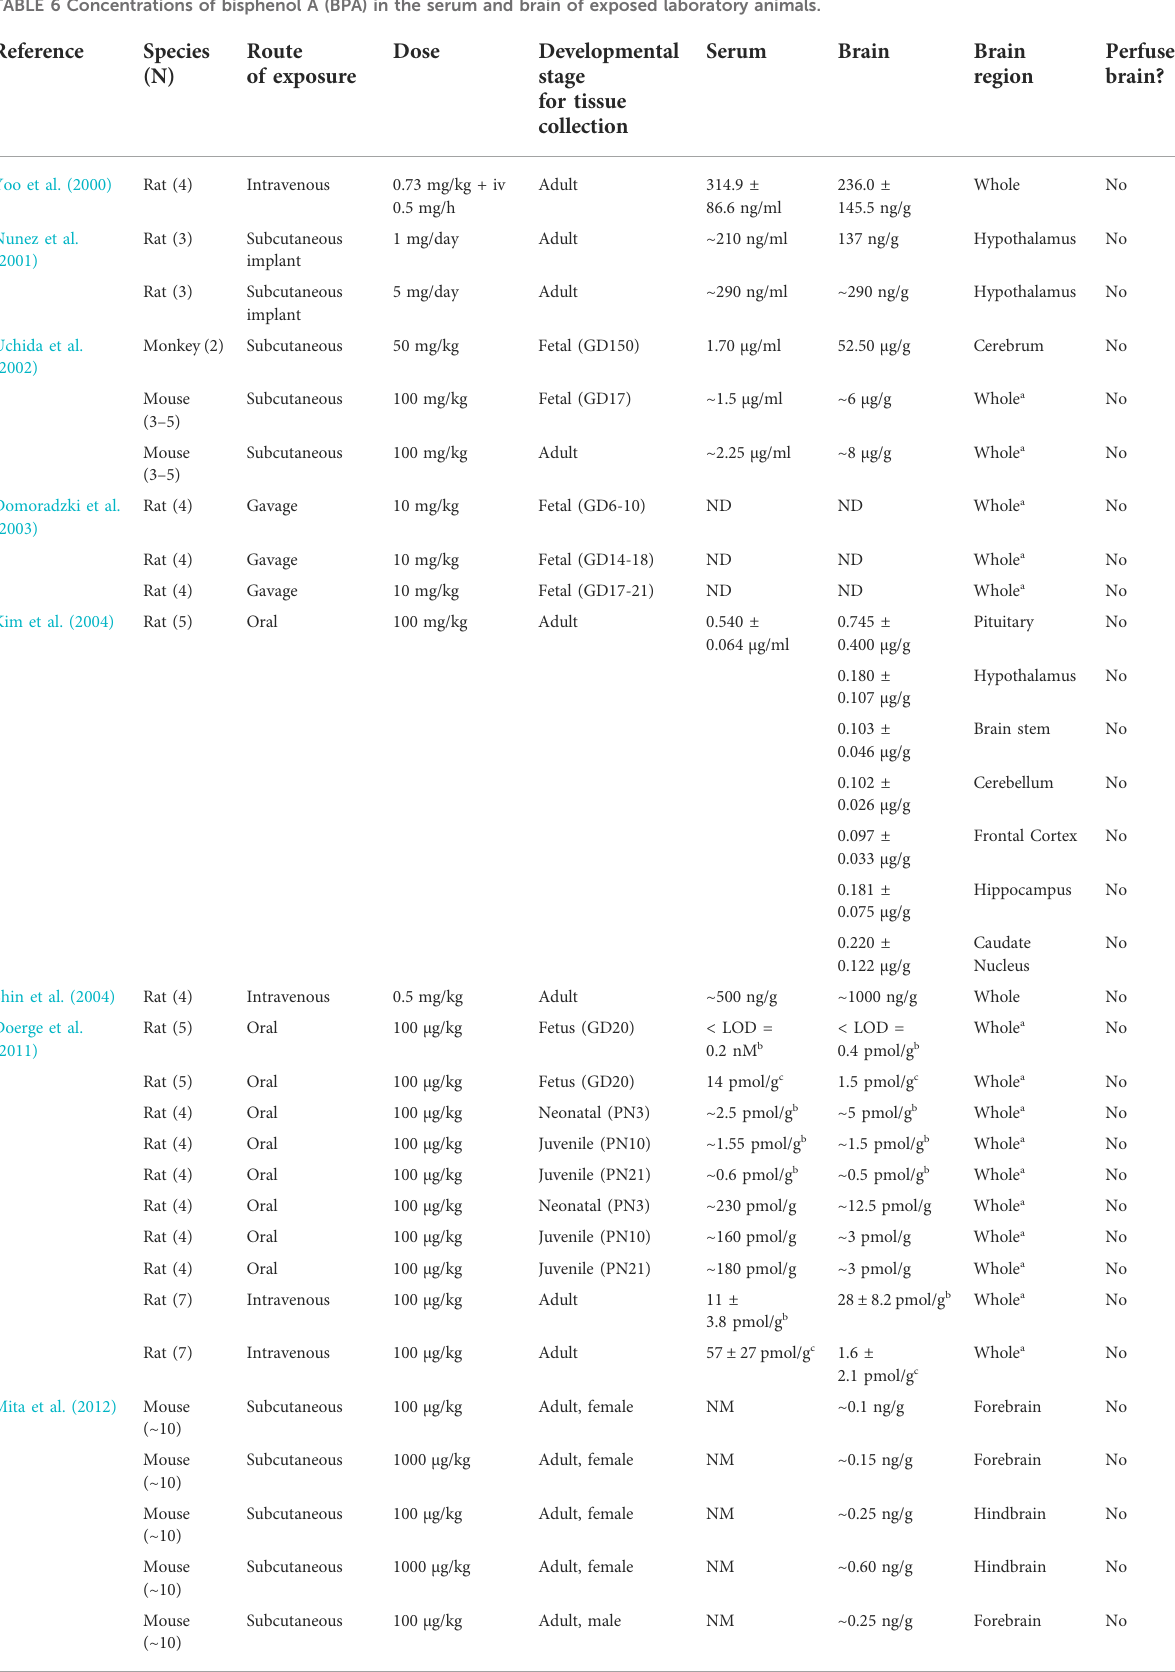
TABLE 6 Concentrations of bisphenol A (BPA) in the serum and brain of exposed laboratory animals.